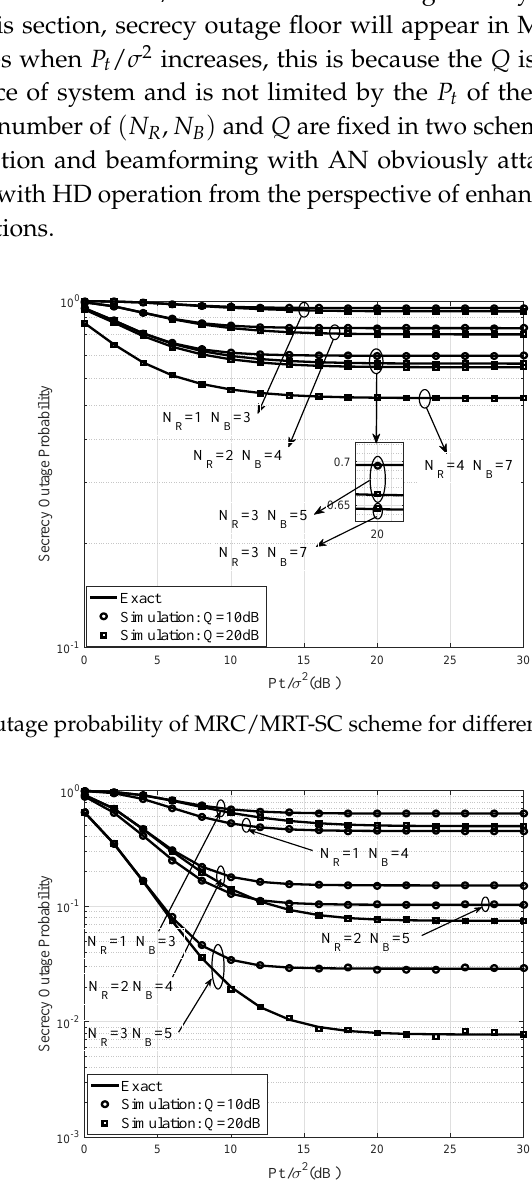
Figure 3. Secrecy outage probability for the MRC-ZFB/MRT-SC-ZFB scheme when γ J = 10 dB and different number N R , N B and Q